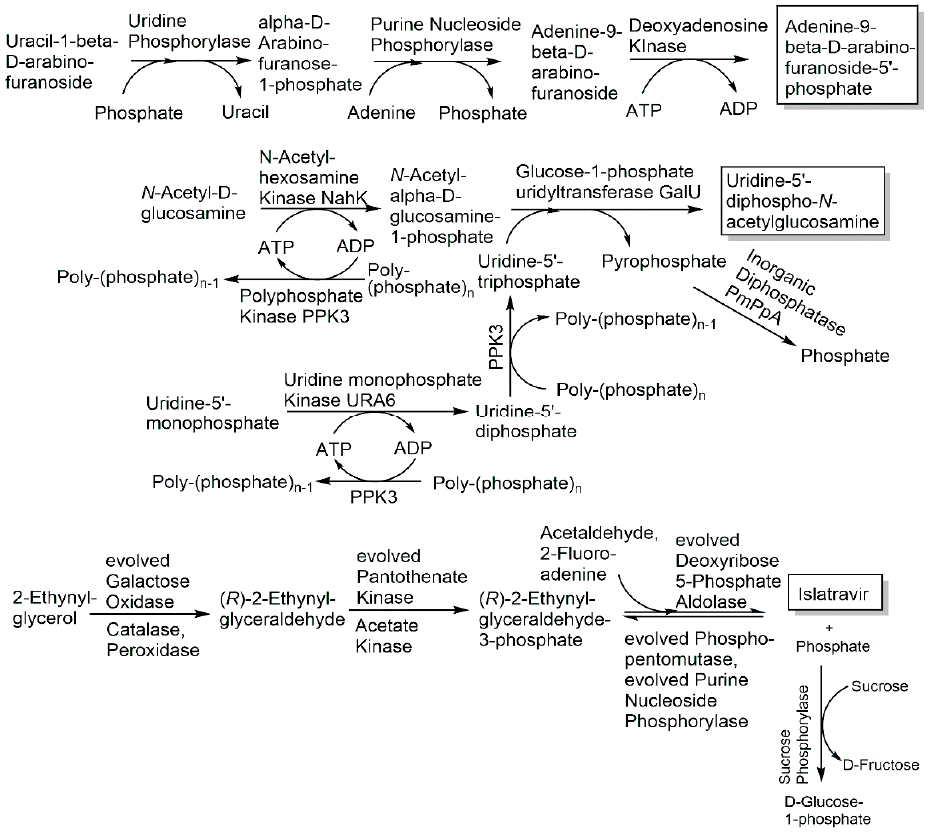
Figure 17. Synthetic reaction cascades involving phosphotransferases, phosphorylases and phosphomutases.